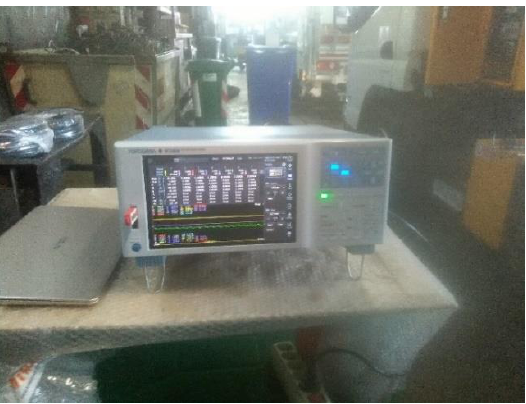
Figure 8. The Yokogawa WT 5000 instrument during the electric measurements.